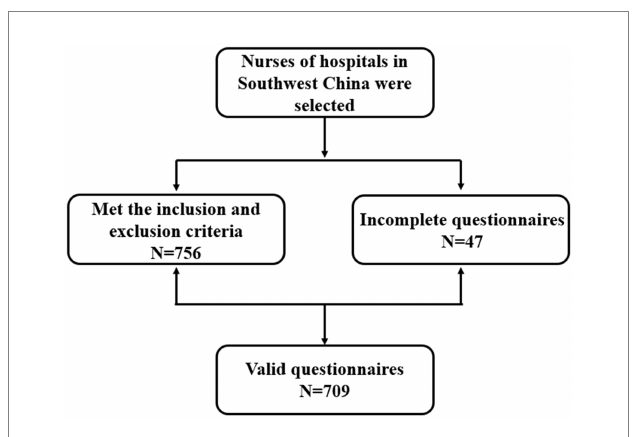
FIGURE 2 The step flow diagram including all steps from screening to